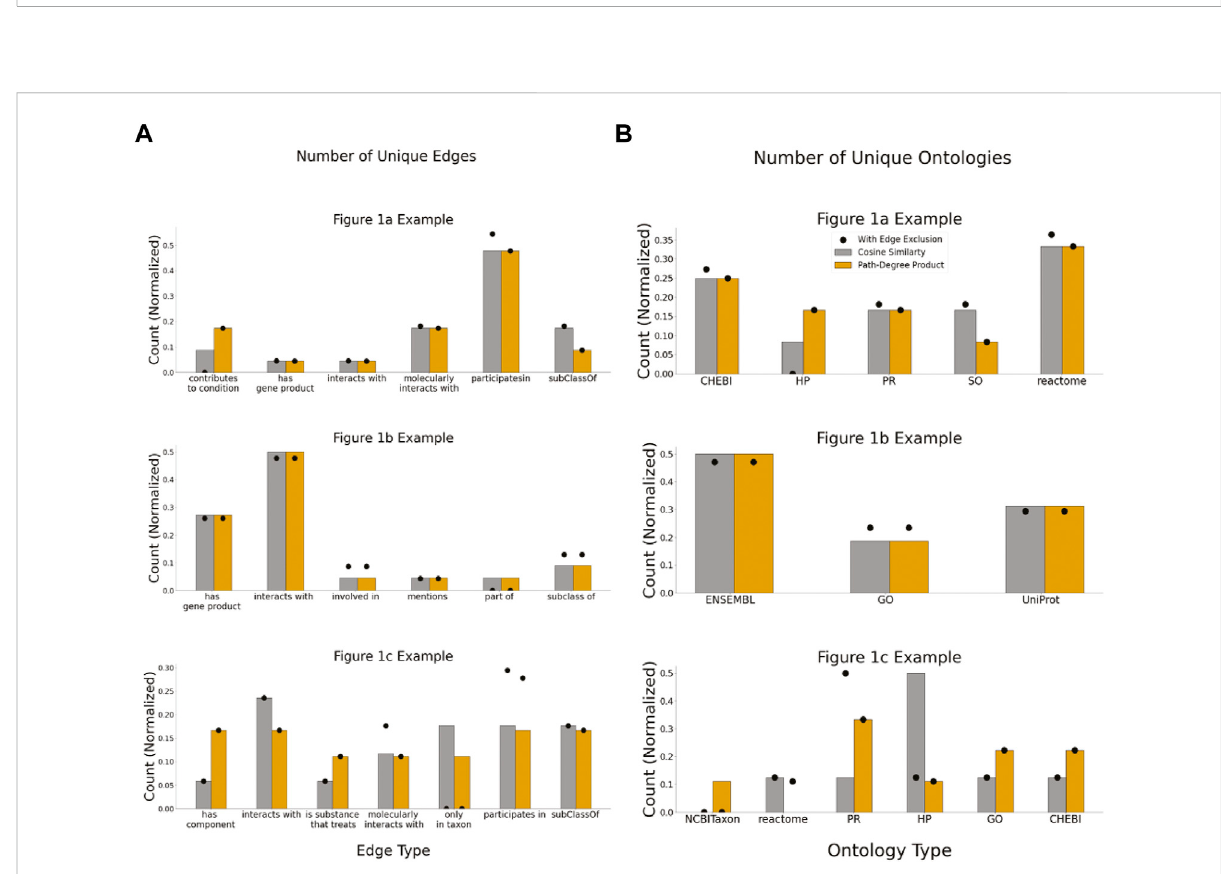
FIGURE 8 Semantic properties of subgraphs generated by each path ranking algorithm. (A) The number of unique edge types within each subgraph generated (B) the number of unique ontologies that make up each subgraph